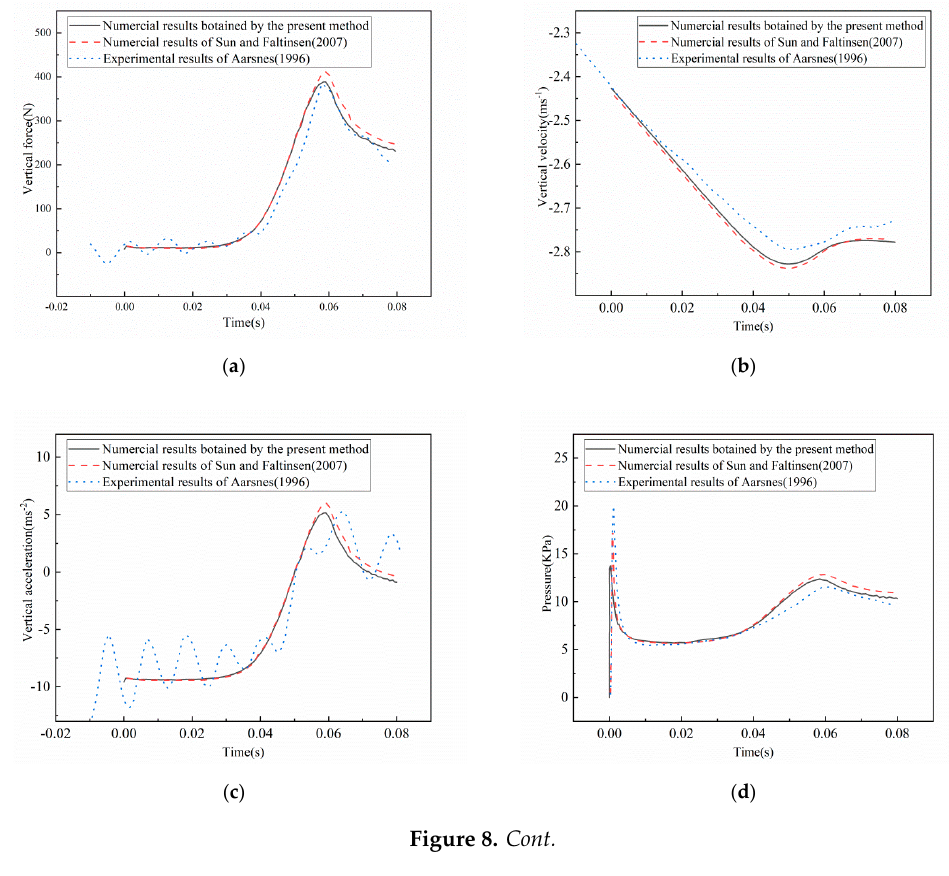
Figure 7. Shape of the bow-flared section in the drop test by Aarsnes (1996).